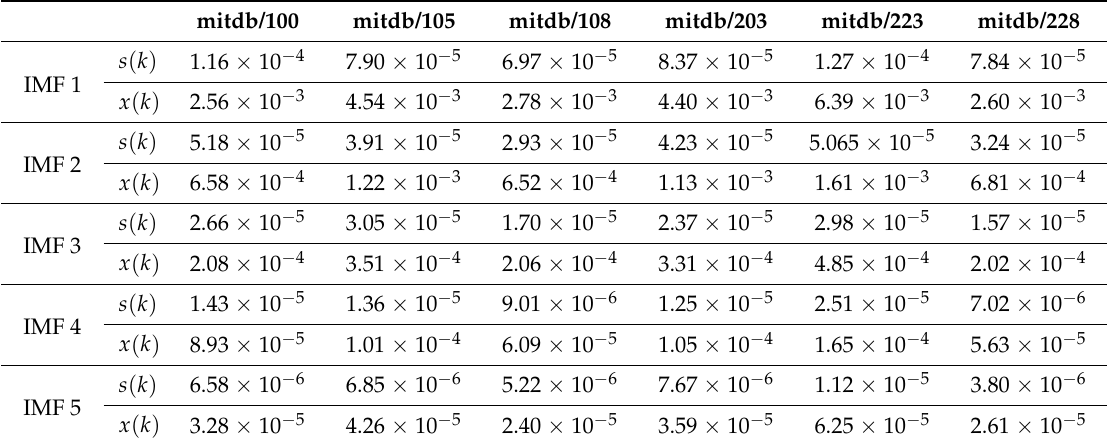
Table 1. The σ | ˆ for clean signal s ( k ) and noisy signal x ( k ) with PLn ( SNR = 5 dB). N ( f ) | Table 1. The 𝜎 |(cid:3015)(cid:3553)((cid:3033))| for clean signal 𝑠(𝑘) and noisy signal 𝑥(𝑘) with PLn ( 𝑆𝑁𝑅 = 5 dB ) mitdb/100 mitdb/105 mitdb/108 mitdb/203 mitdb/100